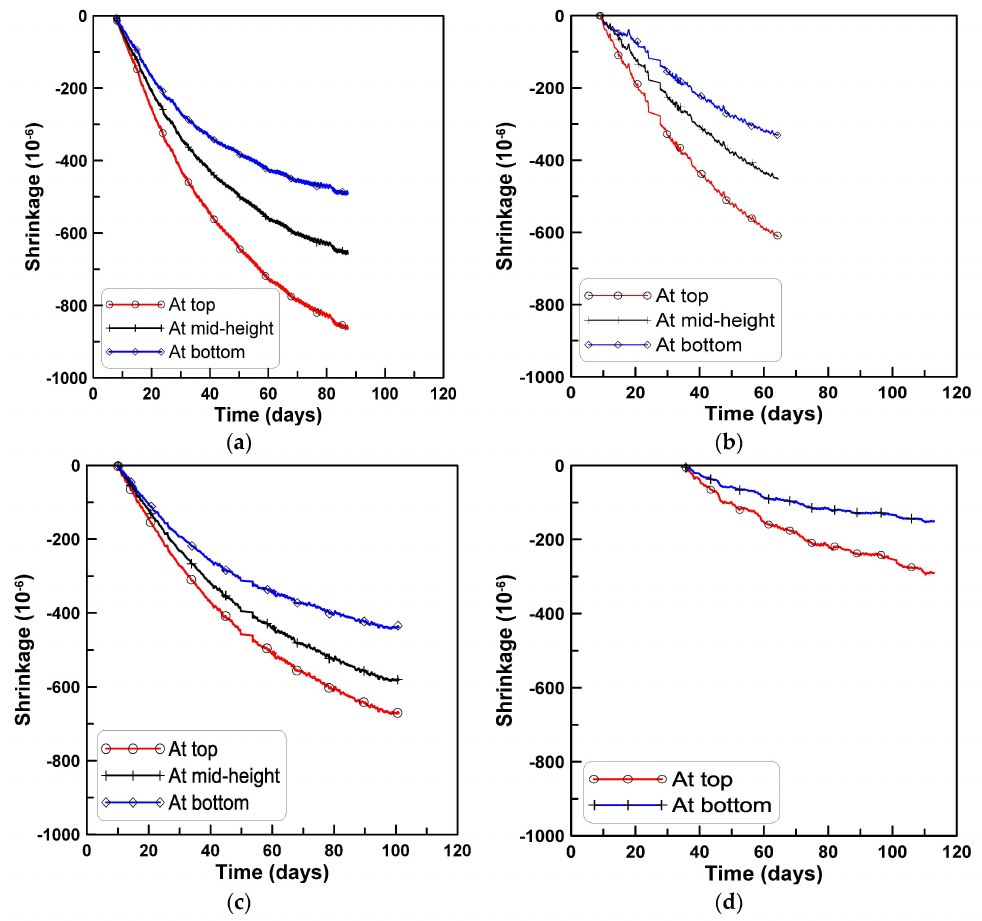
Figure 4. Shrinkage strains of horizontally-cast beam specimens: ( a ) Test series A; ( b ) test series B; ( c ) test series C; ( d ) test series